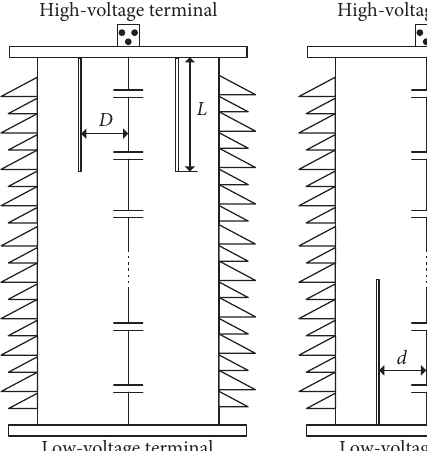
Figure 9: Three types of